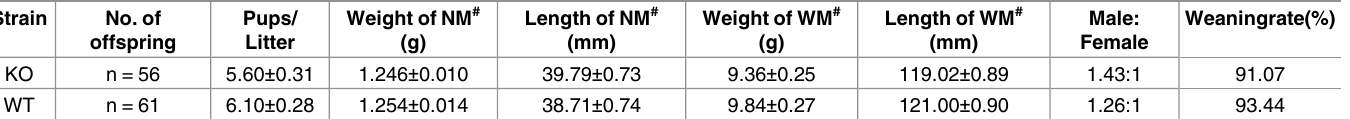
Table 1. Summaryof reproductive performance.